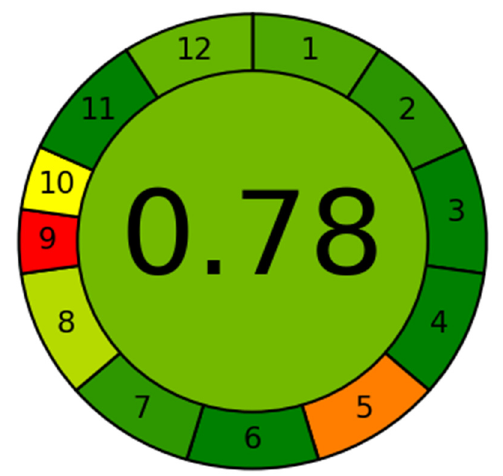
Figure 3. Eco-scale greenness report sheet for the proposed method calculated by using 12 different greenness criteria by AGREE software.